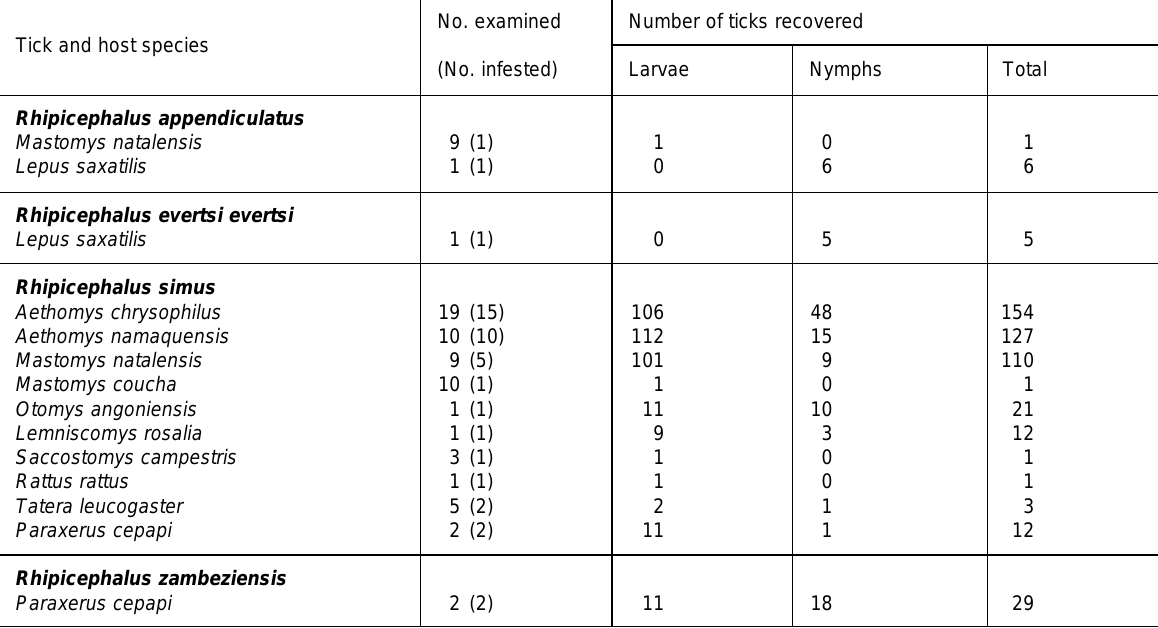
TABLE 5 Rhipicephalus species on small mammals in north-eastern Mpumalanga and Limpopo Provinces No. examined Number of ticks recovered Tick and host species (No. infested)